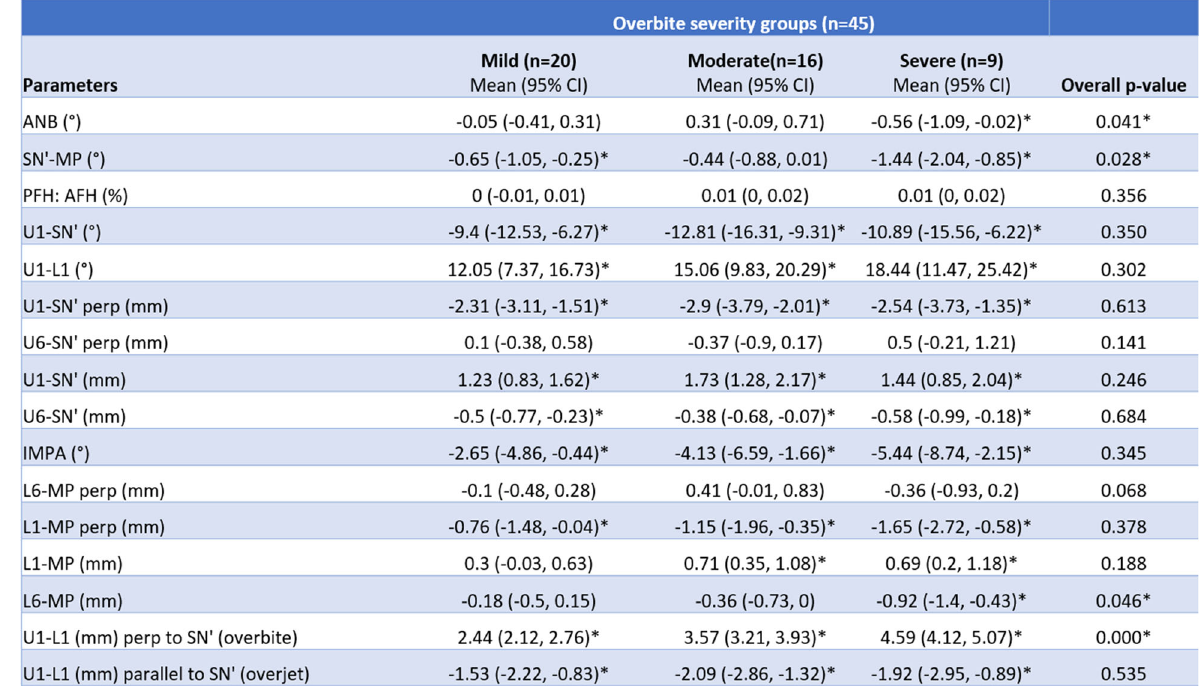
Table 5 Mean treatment changes (T1 – T0) based on pre-treatment overbite